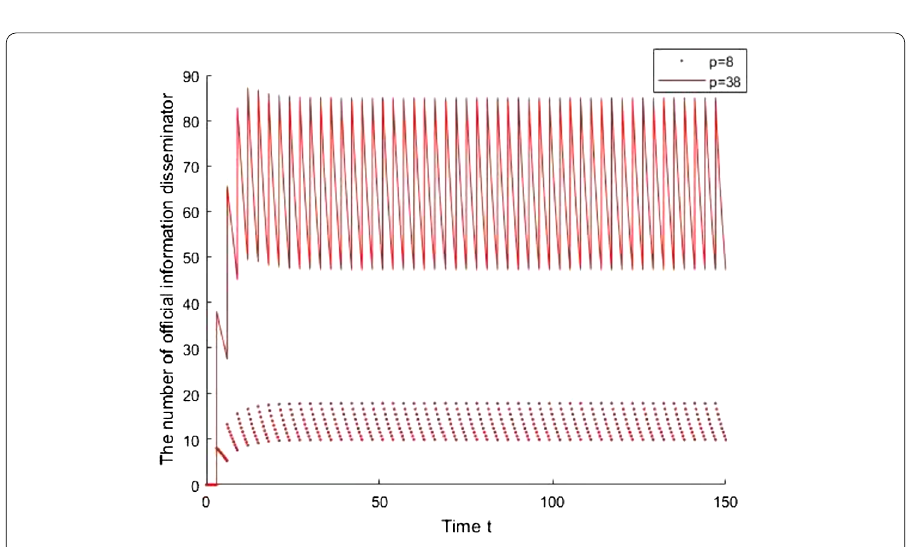
ent values of q , all the official information disseminators y ( t ) oscillate on the same level of positive periodic solution (Fig.